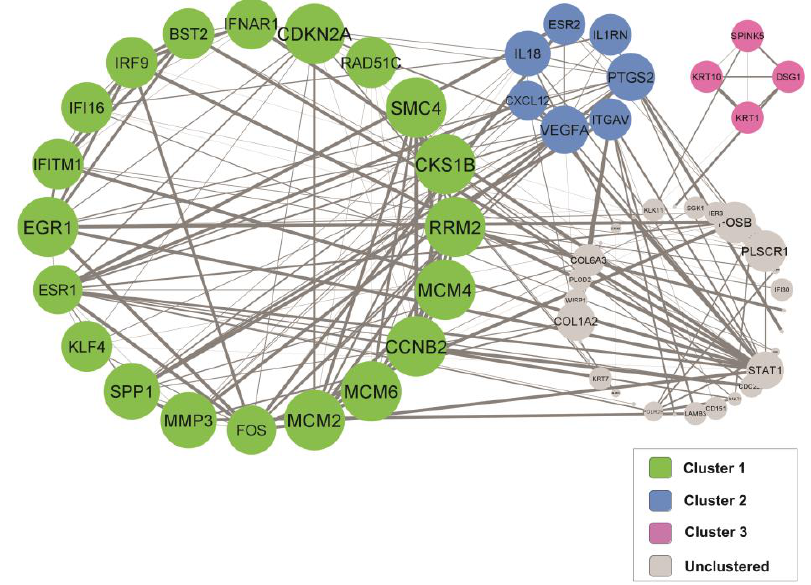
Figure 3. PPI network of the DEGs collected from the selected